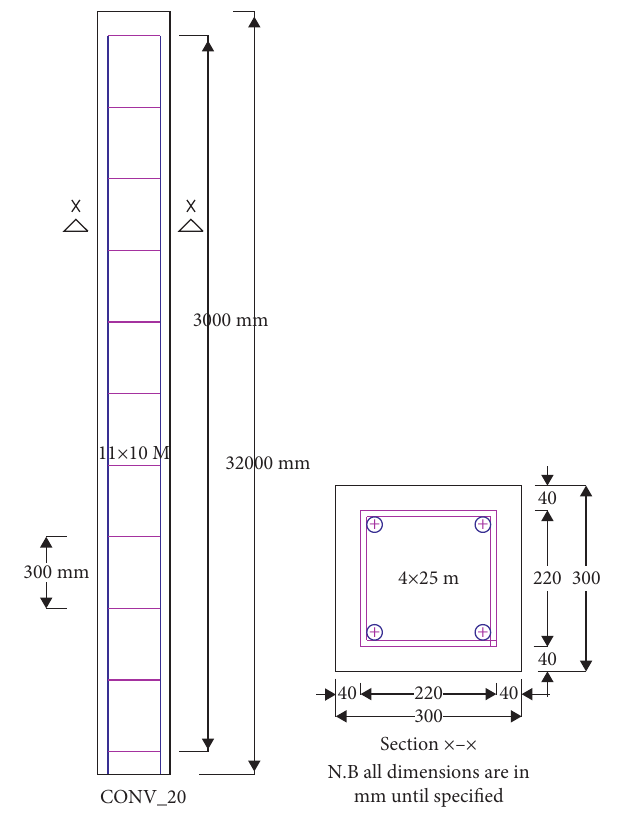
Figure 1: Sketch for CONV_20 RC column.